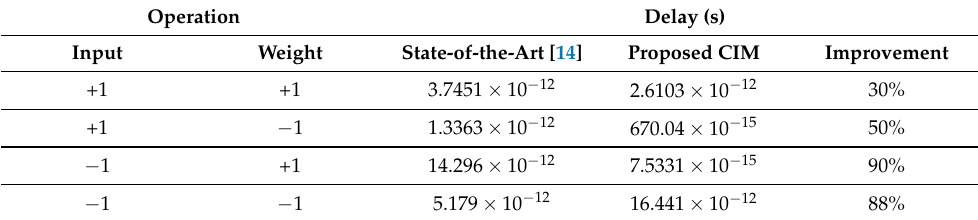
Table 4. Results for